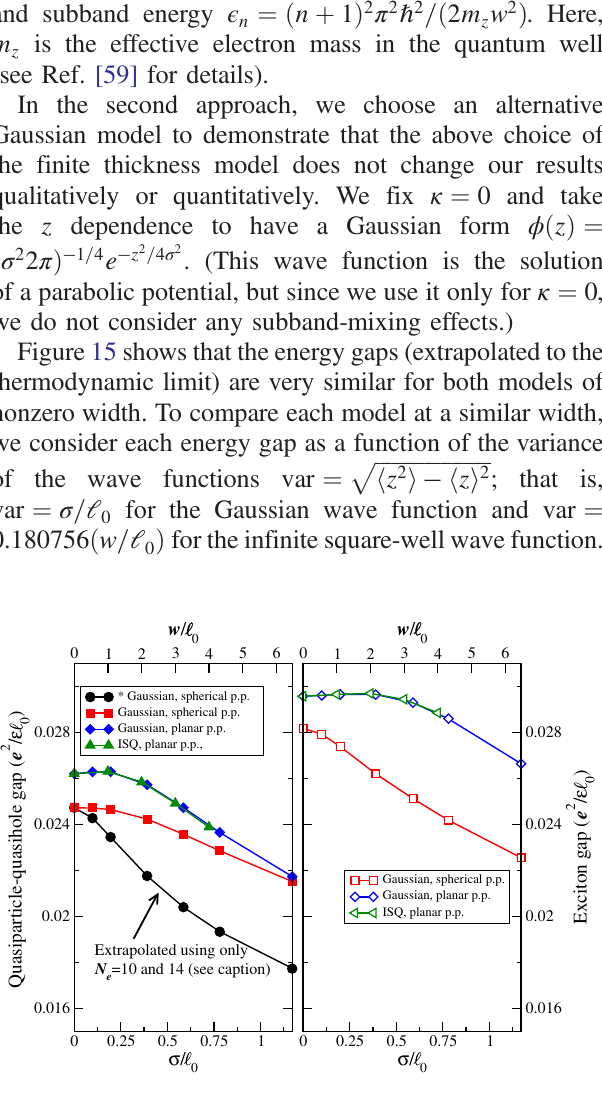
FIG. 15. Extrapolated quasiparticle-quasihole (left panel, filled symbols) and exciton (right panel, open symbols) energy gaps as a function of well width. Each gap is calculated with spherical and planar pseudopotentials (p.p.) for two different models of the finite thickness, Gaussian, and infinite square well (ISQ); see Appendix A. The solid black circles (marked in the legend with an asterisk) are the same as the solid red squares but are obtained from an extrapolation of only N e ¼ 10 and 14 electrons. The solid black circles reproduce the width dependence obtained in Ref. [77] [Fig. 14(b)] to show that using more particles in the extrapolation (the other data points use N e ¼ 10 , 14, and 18 electrons) leads to larger